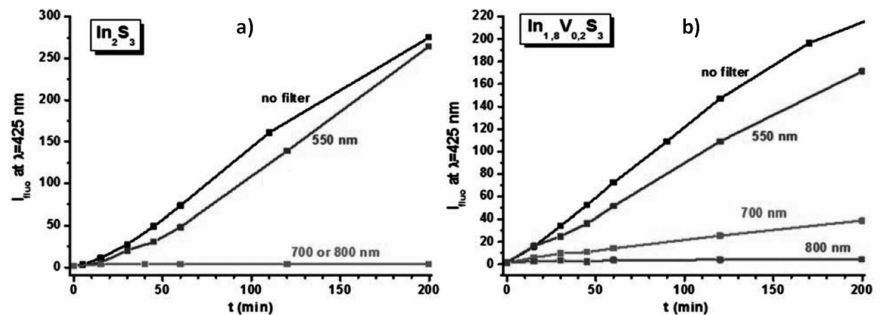
Figure 6. Increase in the fluorescence of hydroxy − terephtalic acid, detected at 425 nm, observed by irradiation at λ = 700 nm not in the case of ( a ), i.e., In 2 S 3 , while V − containing In 2 S 3 ( b ) does show it (Adapted from Ref.